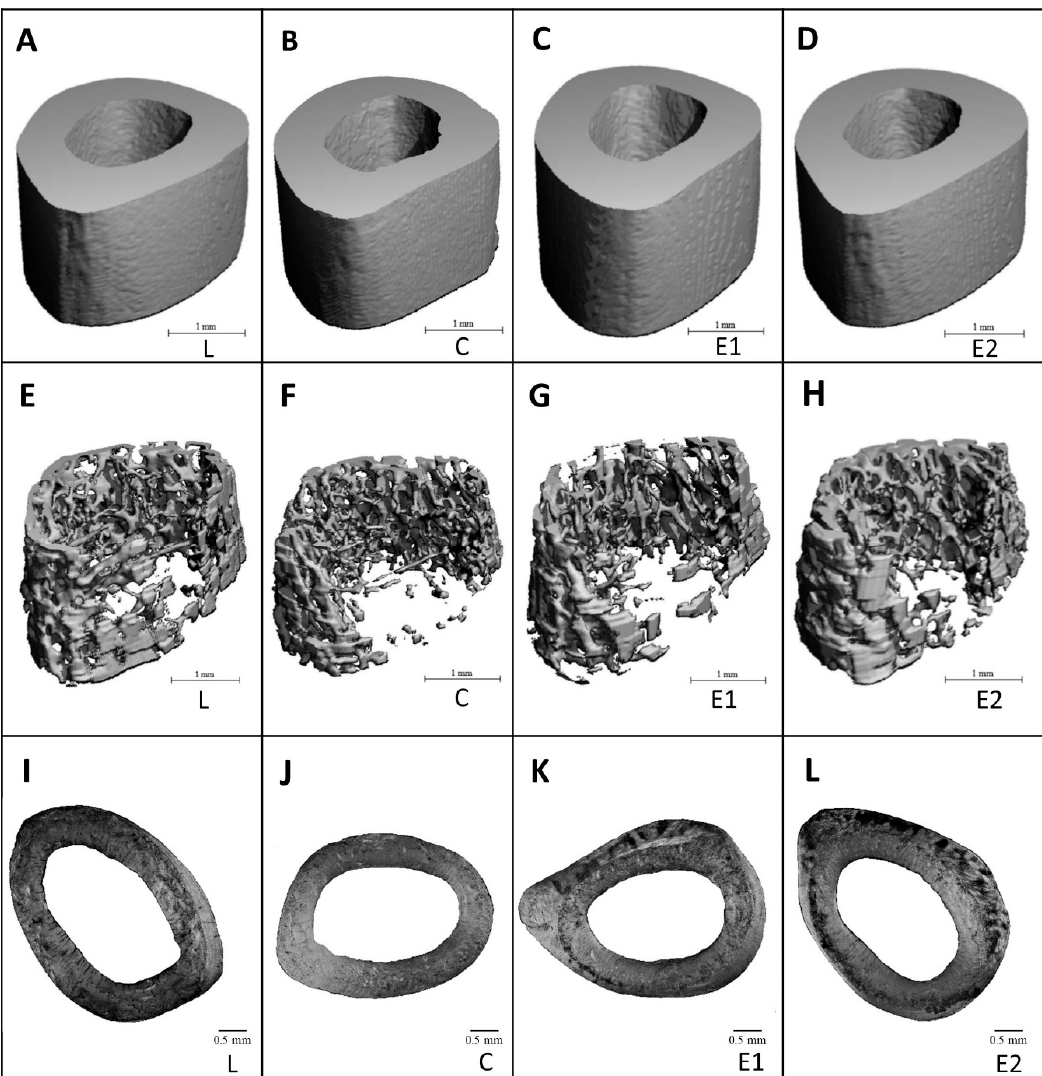
Figure 4. Representative 3D images of cortical ( A – D ) and trabecular bone regions ( E – H ), and representative 2D images of cortical bone ( I – L ) in ZDF rats from L, C, E1 and E2 groups.